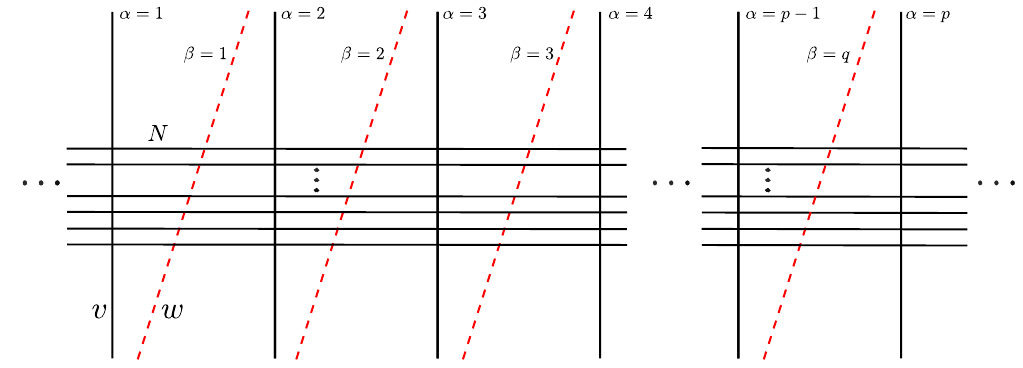
Figure 3 . The brane set-up associated to the Bah-Bobev N = 1 linear quivers. Vertical lines represent NS5-branes extended along f x 4 ; x 5 g , denoted in [55] as v -branes, while diagonal lines represent the NS5’-branes extended along f x 7 ; x 8 g , denoted as w -branes. The same number of D4-branes extended along the x 6 direction stretch between adjacent